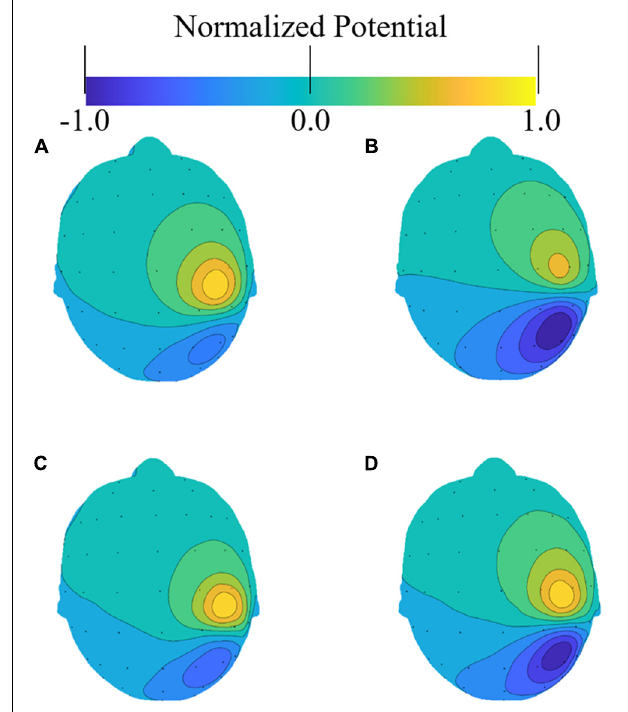
FIGURE 3 | Examples of electric potential distribution on a scalp. Small dots represent the electrode locations as per the international 10–10 system. Potential distributions were normalized with the maximum value on the scalp in the (A) anatomical model, (B) its homogenized model, (C) CSF-insert model, and (D) segmentation-free